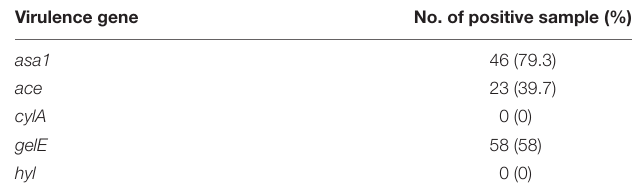
TABLE 4 | Virulence genes of 58 E. faecalis isolates.